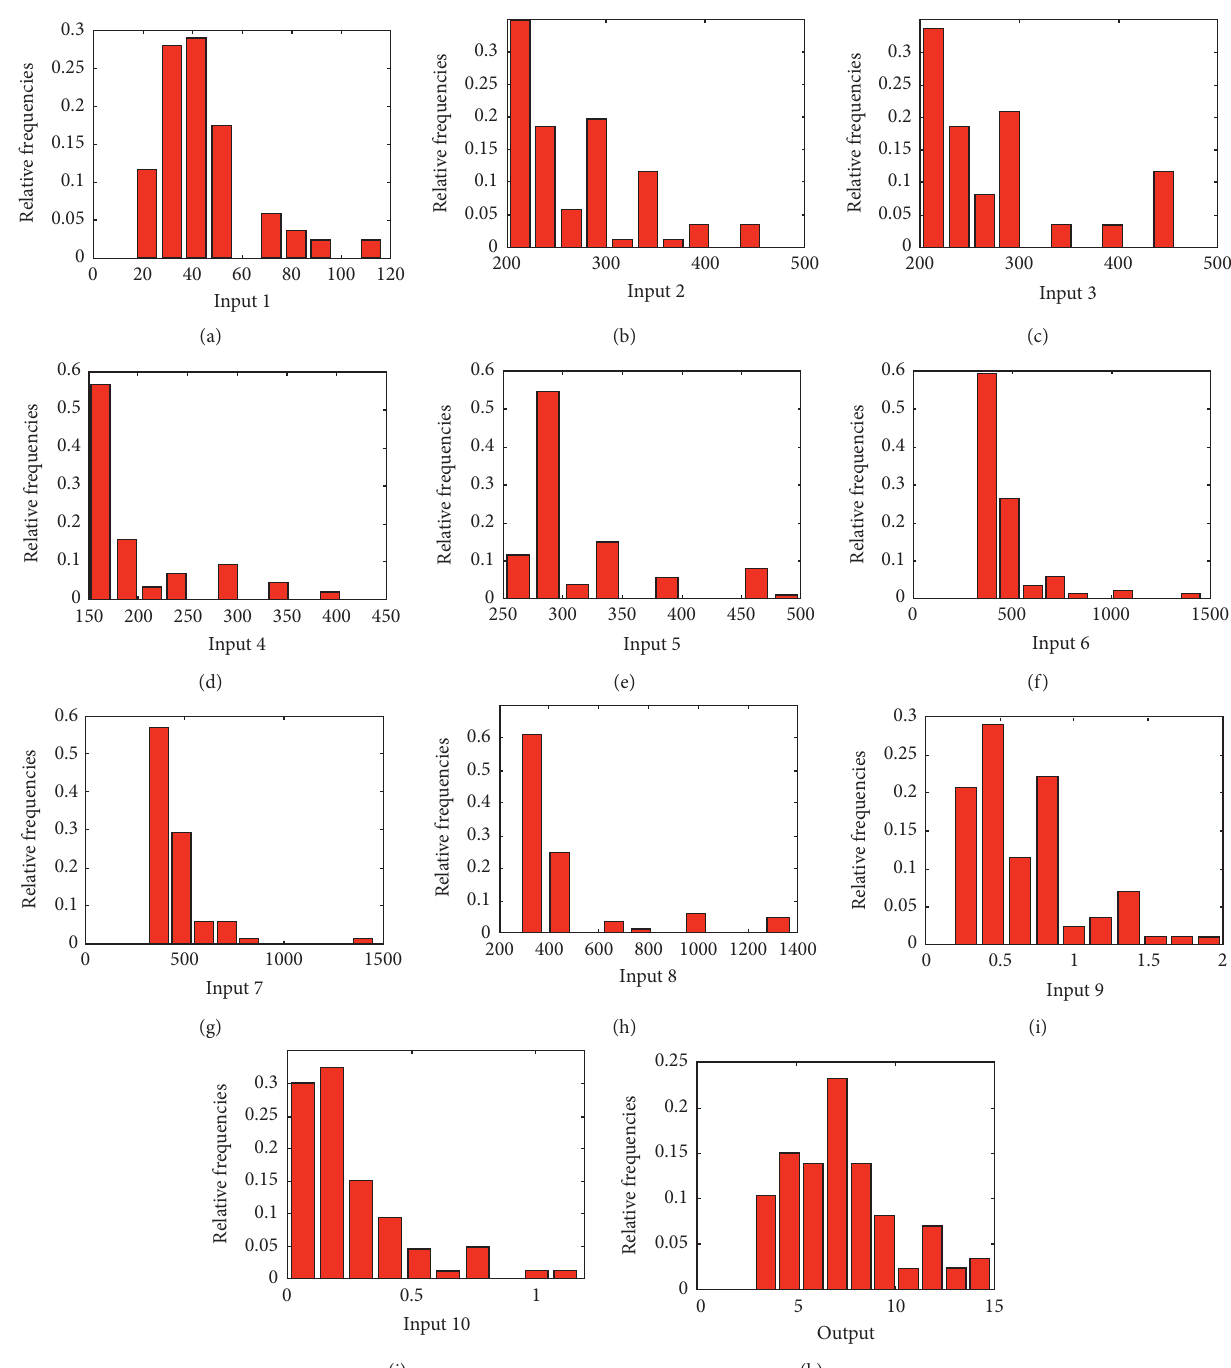
Figure 2: Statistic distribution of the input and output parameters. (a) Concrete strength (MPa). (b) Section width of column (mm). (c) Section height of column (mm). (d) Section width of beam (mm). (e) Section height of beam (mm). (f) Yielding strength of beam longitudinal bar (MPa). (g) Yielding strength of column longitudinal bar (MPa). (h) Yielding strength of joint transverse bar (MPa). (i) Transverse bar ratio (%). (j) Axial load ratio. (k) Joint shear strength